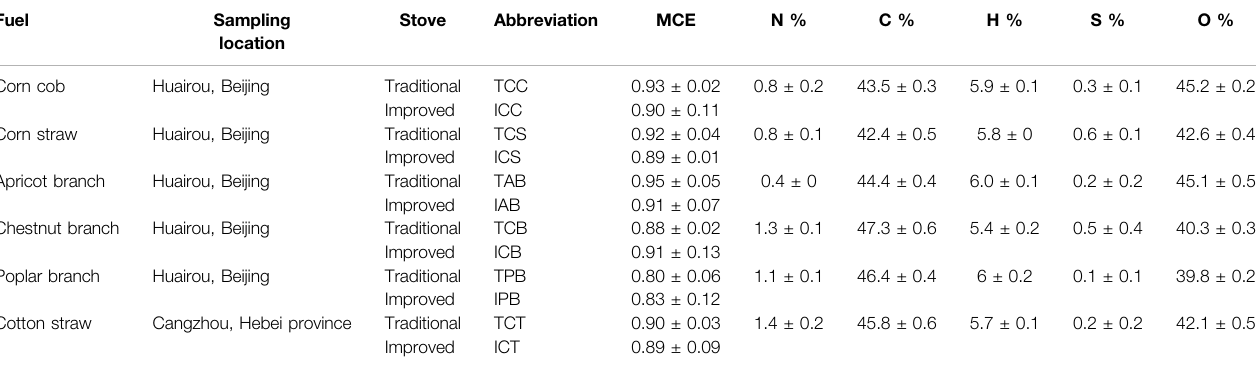
TABLE 1 | Sample information and fuel properties.